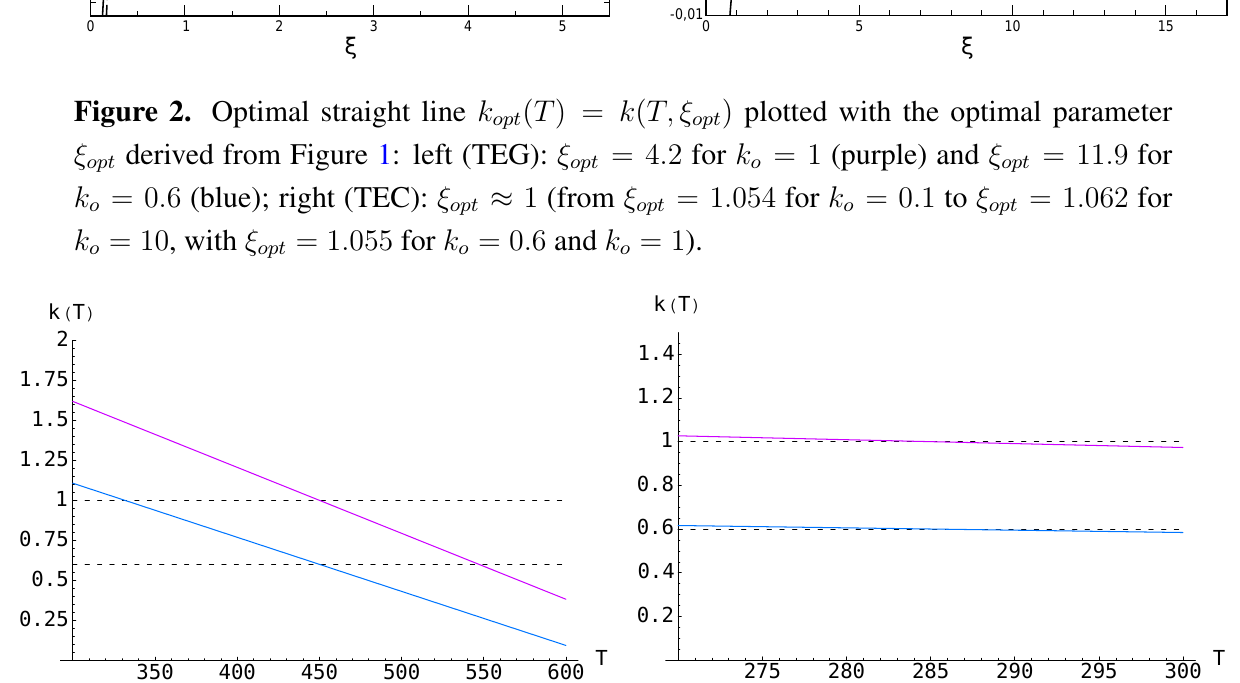
= 11 . 9 for opt = 1 . 062 for opt